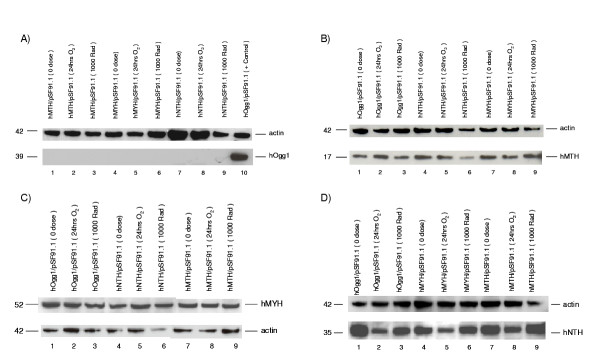
Western analysis of A549 cells over-expressing individual repair genes and effect on endogenous glycosylase level. (A) Endogenous expression of hOgg1 was not altered in A549 cells over-expressing any of the other repair genes when analyzed after non-toxic and toxic exposures. hOgg1 protein was not detectable for any of the cells under the above conditions when compared to cells over expressing hOgg1. (B) and (C) Endogenous expression of hMTH and hMYH respectively also were not altered in A549 cells over-expressing any of the other repair genes when analyzed after non-toxic and toxic exposures. (D) Endogenous expression of hNTH was analyzed under non-toxic and toxic conditions in A549 cells over-expressing the other repair genes. Reduced expression of hNTH was observed equally with all of the other genes after exposure to 95% O2. Endogenous expression of all four genes was equivalent under the above conditions in vector control cells; pSF91.1 (data not shown).